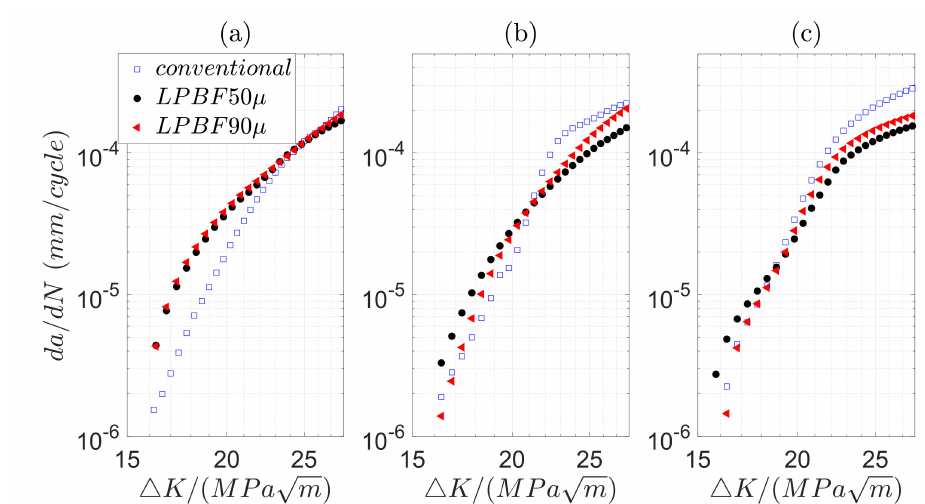
Figure 5. Fatigue crack growth kinetics of 316L SS at different corrosion fatigue parameters for conventional (labeled as conventional) and two LPBF samples at H = 90 µ m and H = 50 µ m (la-beled as LPBF90 µ and LPBF50 µ , respectively) at R = 0.1 in ( a ) air, ( b ) 3.5 wt.% NaCl solution at 20 Hz and ( c ) 3.5 wt % NaCl solution at 2 Hz.